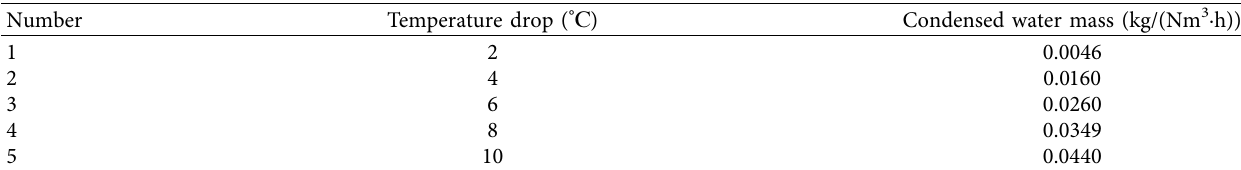
Table 2: Recovered mass of condensed water with the heat exchanger